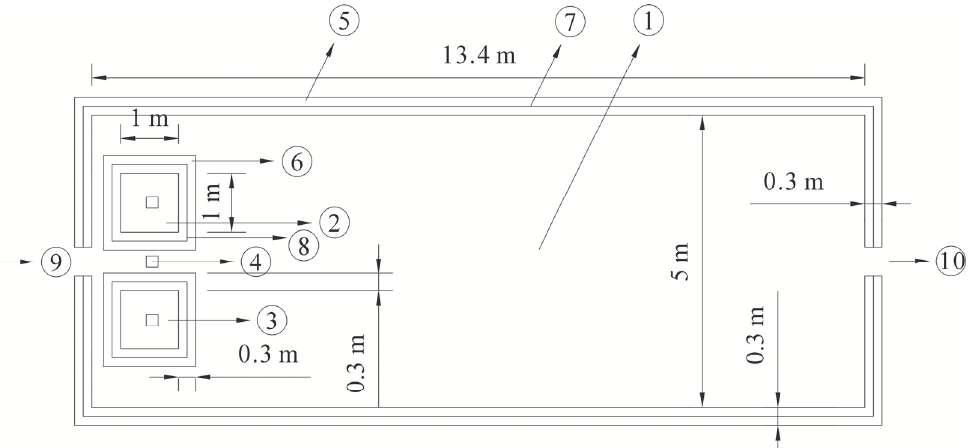
Table 1. Paddy field water depth at different rice growth stage (mm). PTS is